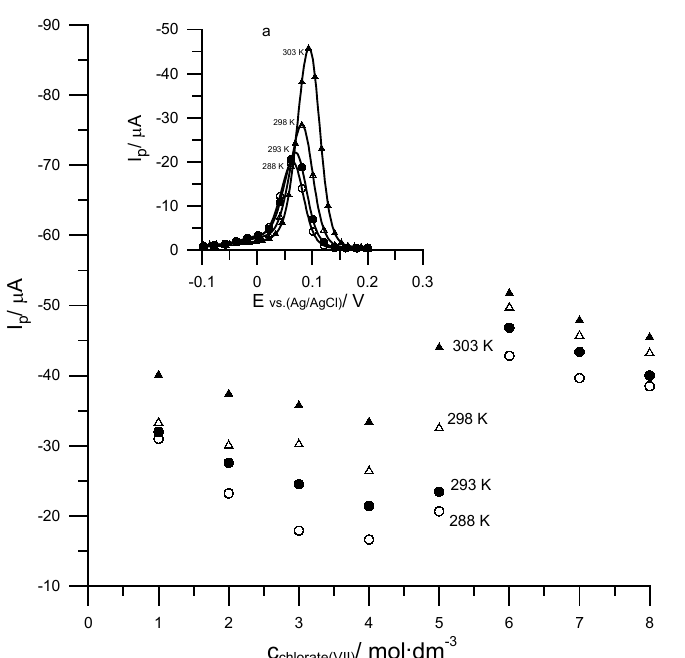
Figure 1. Dependence of the SWV peak current of 1×10 -3 mol dm -3 Bi(III) in chlorates (VII) in the presence 1×10 -2 mol dm -3 cystine on chlorate (VII) concentration, in the studied temperature range: ( ○ ) 288 K, ( ● ) 293 K, ( D ) 298 K, ( ▲ ) 303 K. Fig. 1a.: SWV peaks of 1×10 -3 mol dm -3 Bi(III) electroreduction in 4 mol dm -3 chlorates (VII) in the presence of 1×10 -2 mol dm -3 cystine, in the studied temperature range: ( ○ ) 288 K, ( ● ) 293 K, ( D ) 298 K, ( ▲ ) 303 K